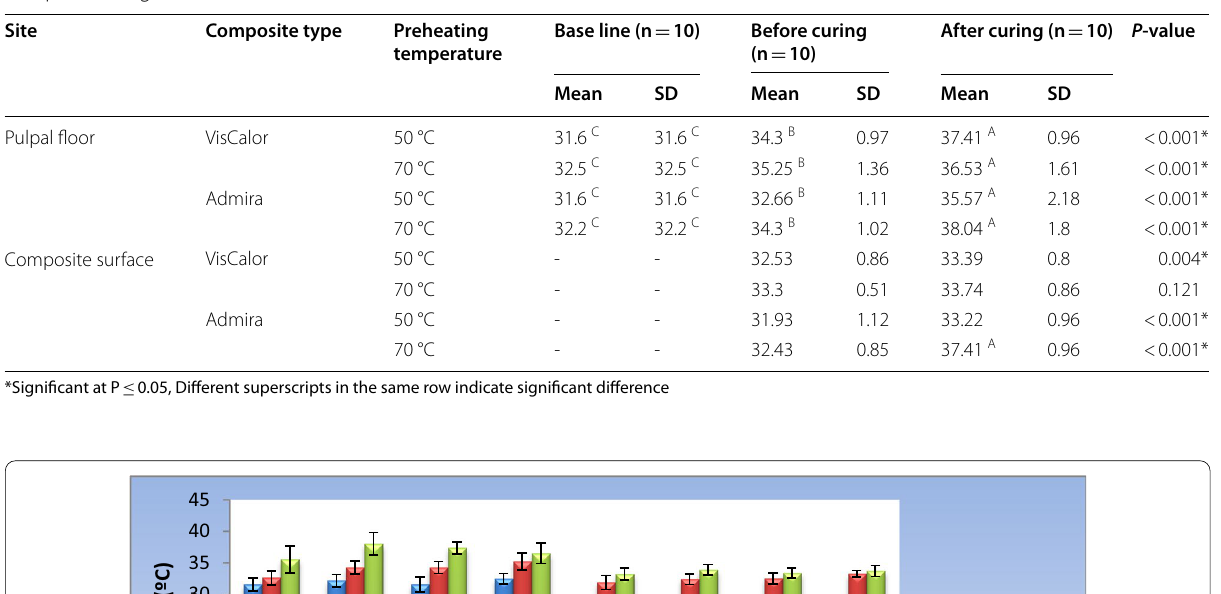
Table 3 Results of repeated measures and descriptive statistics temperature measurements (°C) before and after curing were compared using the ANOVA test